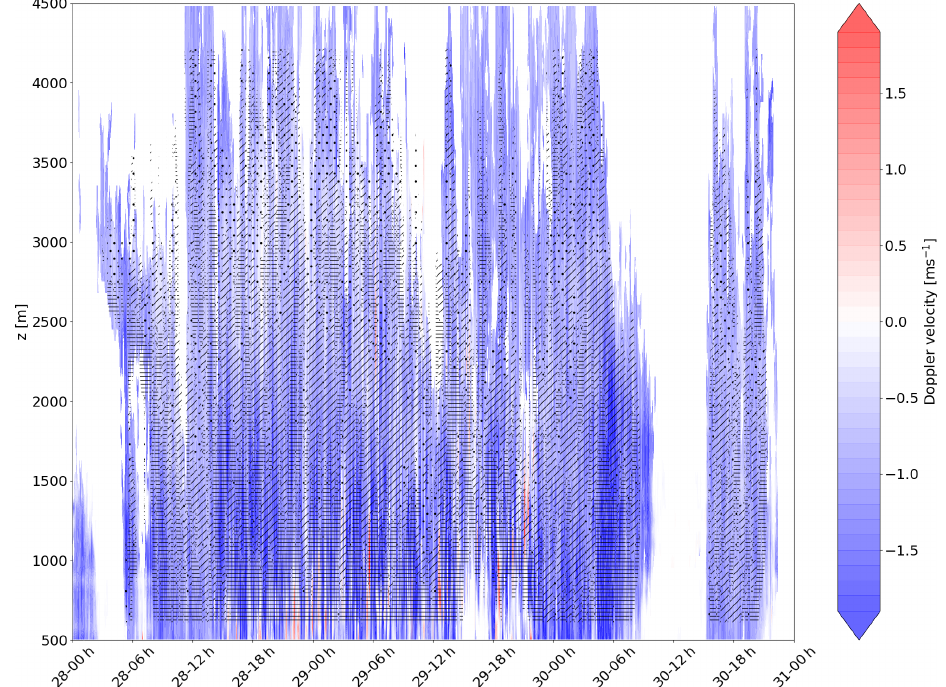
Figure A1. Vertical Doppler velocity time–height plot during EV2 (WProf data). We superimpose the PIVS output, i.e., dots ∴ stand for CG, // stand for AR and ≡ stand for SUB.